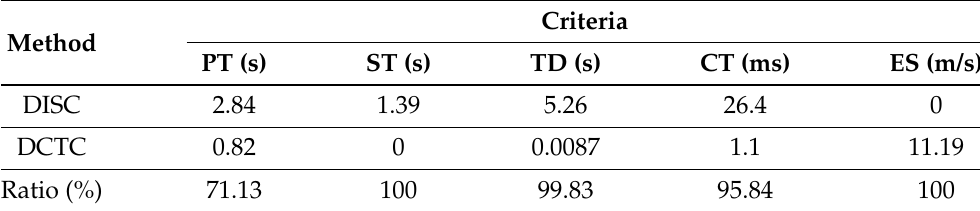
Table 8. Comparison between DISC and DCTC.